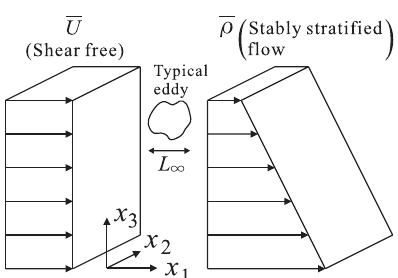
Fig. 1 Schematic of flow condition. A shear-free, stable stratified flow with a constant negative density gradient is considered. The initial ( t < 0) turbulence is assumed to be